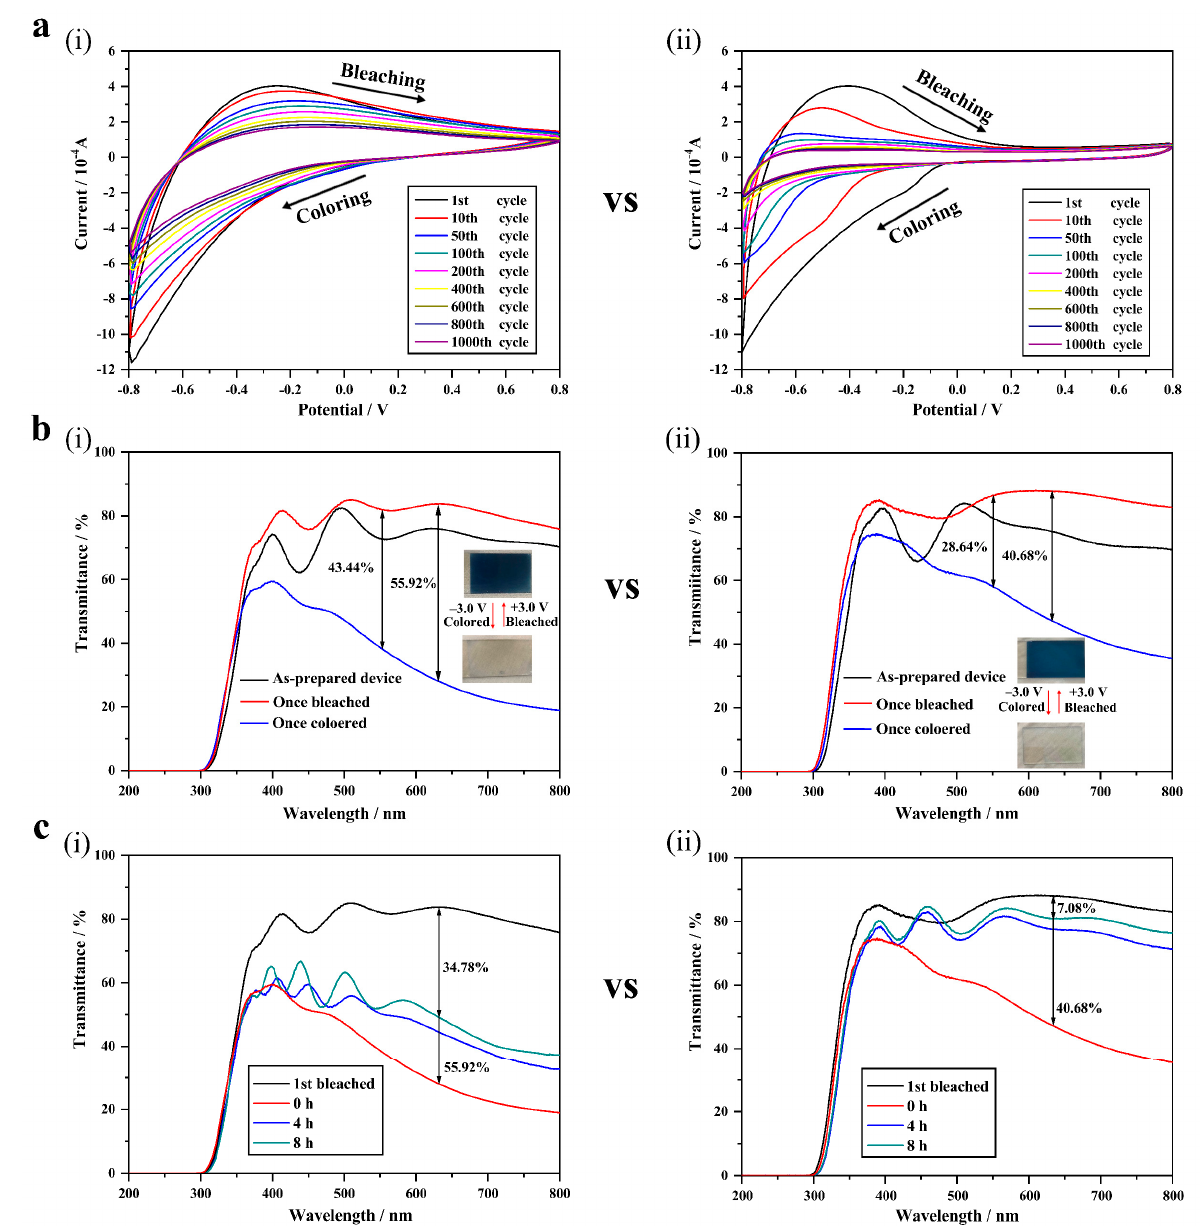
Figure 7. Comparison of the electrochromic properties of the nanostructured WO 3 film ( i ) and the ordinary WO 3 film ( ii ). ( a ) the cyclic stability, ( b ) the optical modulation rates, ( c ) the memory effect.